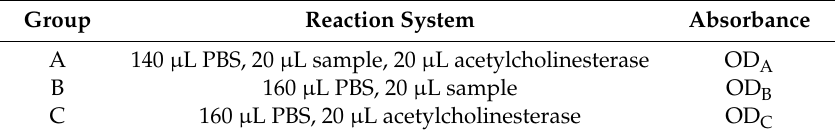
Table 3. Specific grouping and reaction system for acetylcholinesterase inhibitory